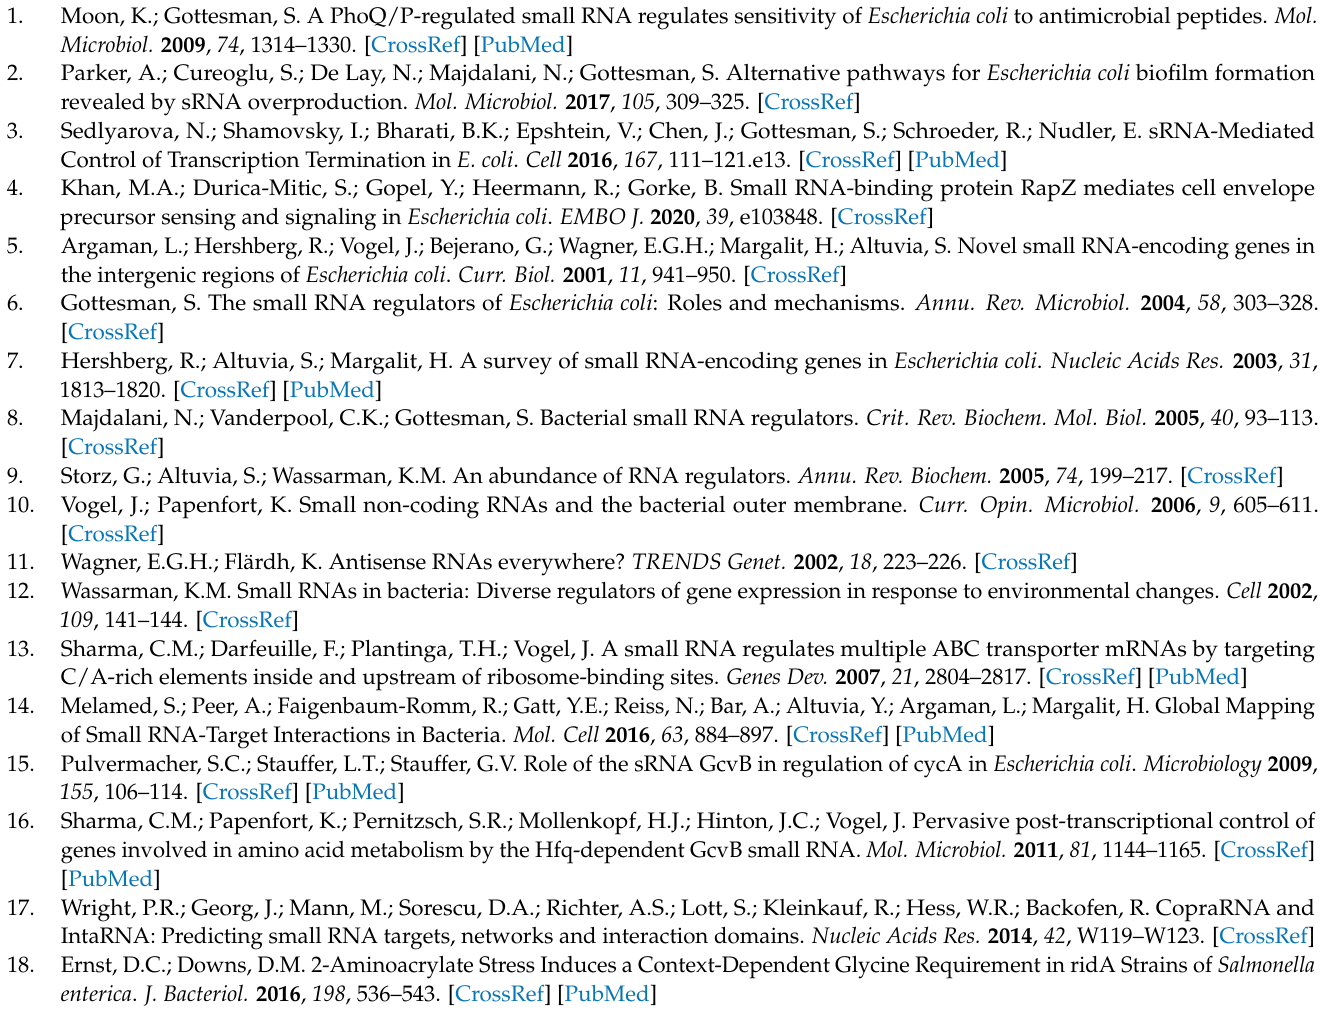
Table S2: Primers used for RT-qPCR, Table S3: DEGs identified between the gcvB knockout and wild-type